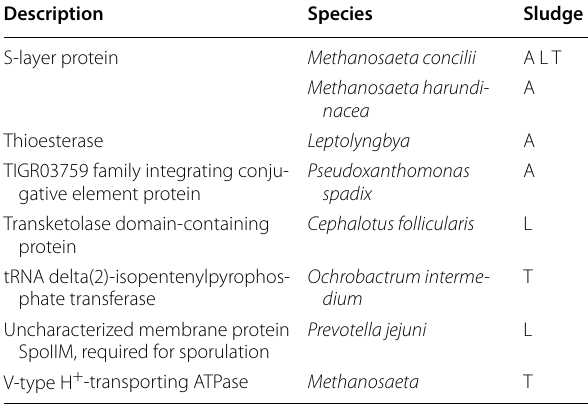
Additional file 1: Figure S1. Measured protein concentration. Figure S2. Measured concentration of humic substances. Figure S3. Microphoto‑ graphs of sonicated granules, showing alive cells. Table S1. Analysis of the protein fraction of the extracellular polymeric substances by tandem mass